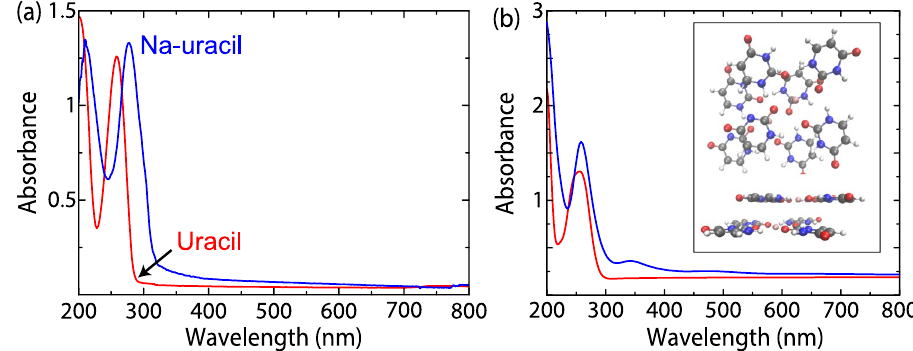
Figure 2. ( a ) The measured absorption spectra of uracil reference (red) and Na-uracil thin film (blue). ( b ) Calculated absorption spectra of uracil (red) and Na-uracil (blue) and the Na-uracil structure used for modeling in the inset. The individual optical transitions have been folded into smooth curves by using a Gaussian width of 0.2